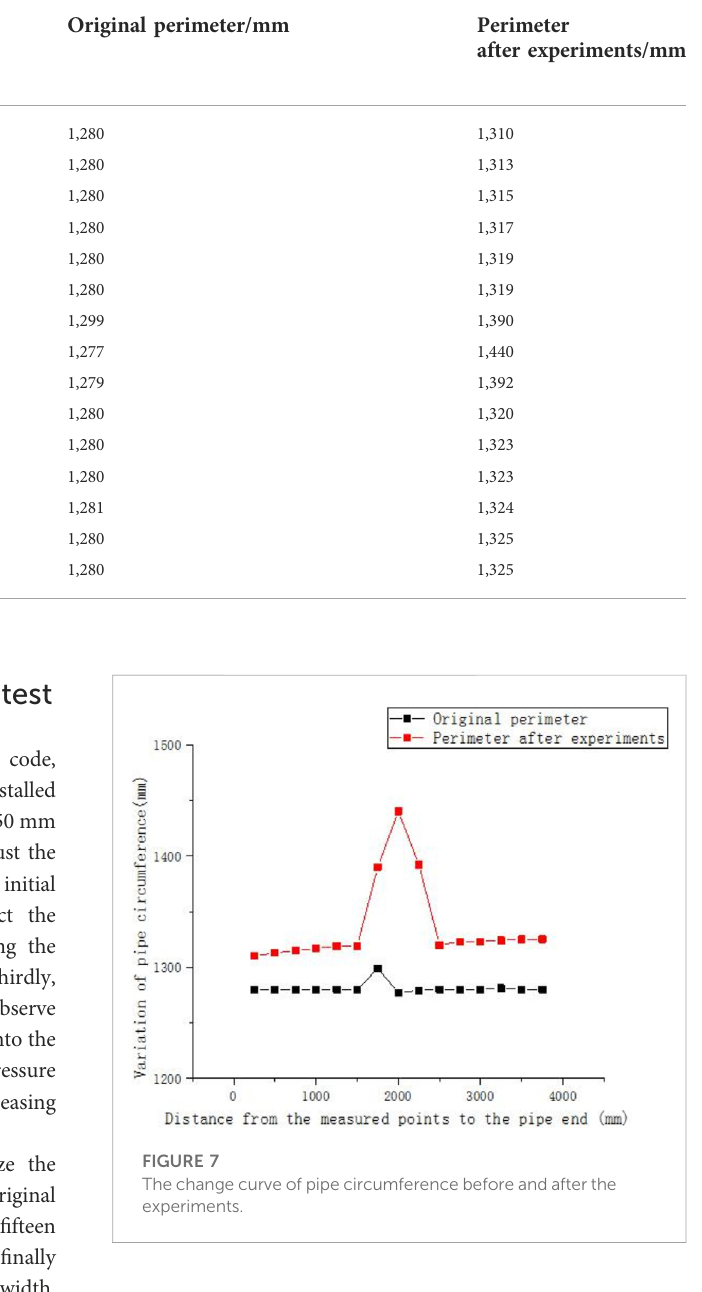
TABLE 4 Comparisons between the original perimeter and perimeter after experiments for sample #1.